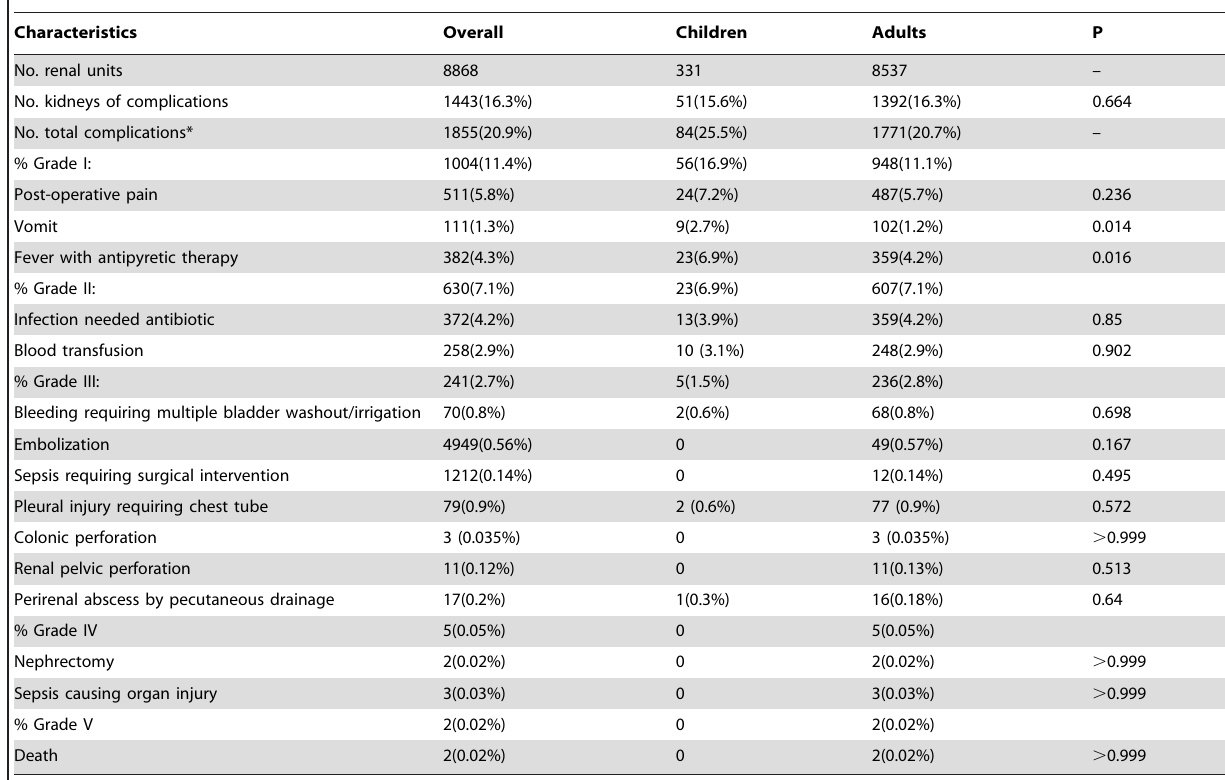
Table 3. Complications by modified C lavien